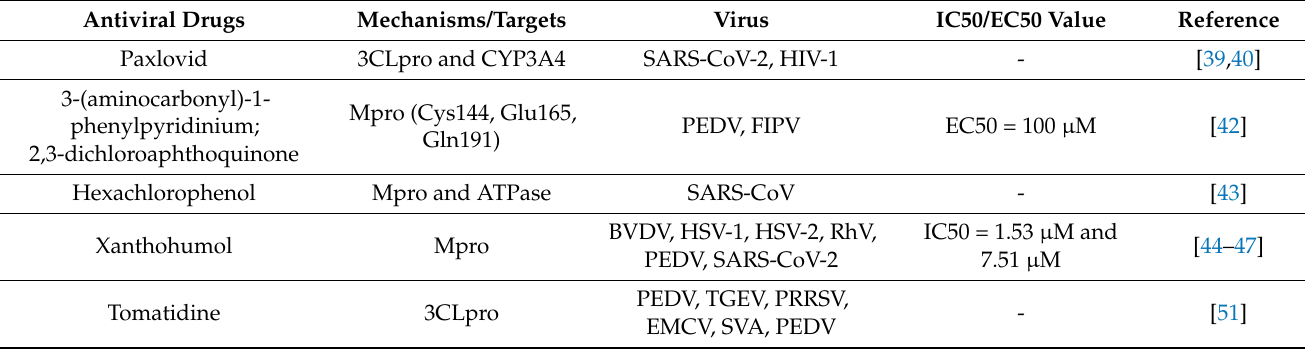
Table 2. Antiviral enzyme inhibitors and the antiviral